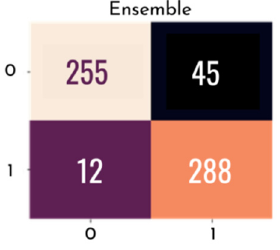
Figure 15. Area under the ROC curve (AUC) for the ensemble model, each row corresponds to one round of cross-validation.